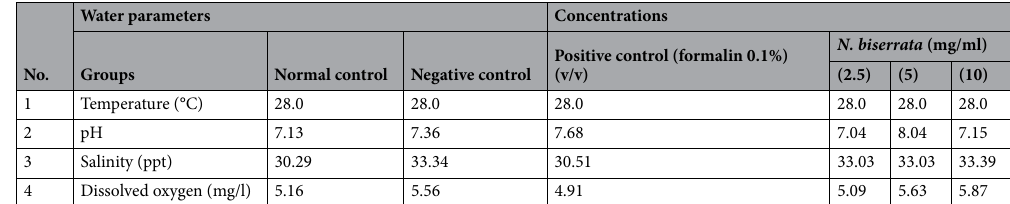
Table 4. Water quality parameters of the solutions applied for the fish treatment.